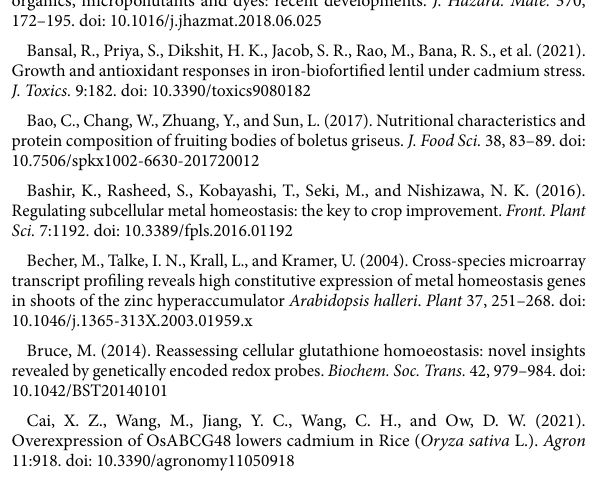
SUPPLEMENTARY FIGURE S1 Heat map of correlation between transcriptome samples of Hypomyces chrysospermus